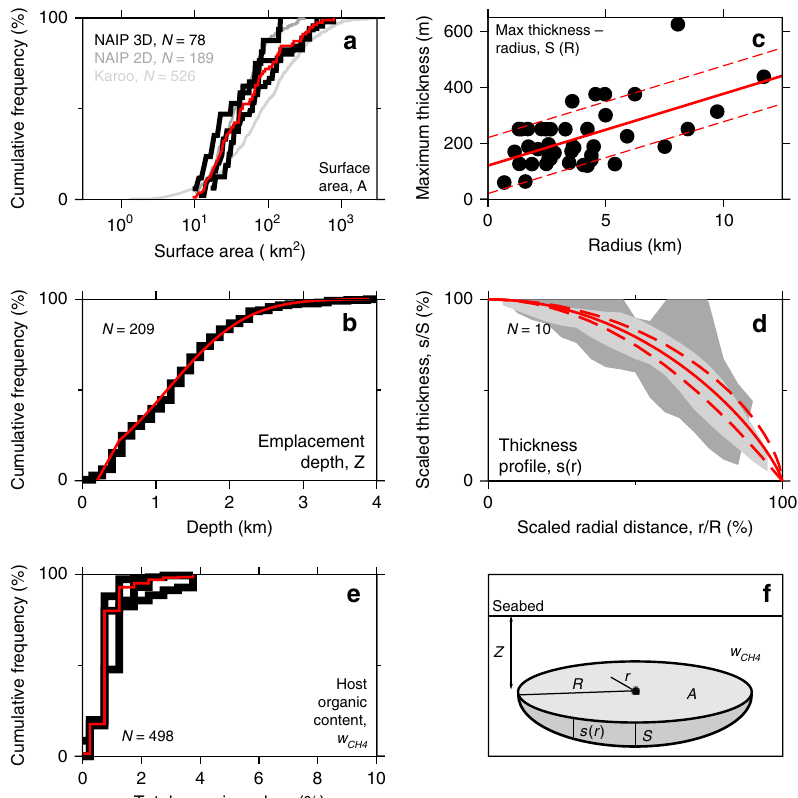
Fig. 4 Sill dimension observations used for stochastic modelling. On all panels, black lines and grey areas show observations, red lines show distributions used in stochastic modelling. a Cumulative distribution of sill surface area. Black lines show observations from three 3D surveys close to the centre of the NAIP, and therefore most likely responsible for peak emissions: Faroe-Shetland Basin (excluding Judd sub-basin), Judd basin and NE Rockall basin. Dark- grey line shows observations from 2D survey compilation from Rockall Basin. Light-grey line shows observations from satellite imaging of Karoo sills (for reference; excluded from de fi nition of red line used for stochastic modelling here). b Cumulative distribution of sill emplacement depth, measured from sills imaged on 2D and 3D seismic data across the NAIP basins and around the world. c Maximum thickness versus diameter for sills for which clear re fl ections from both top and bottom of the sill are observed on seismic data. d Pro fi les of scaled sill thickness versus scaled radial distance. Grey envelopes represent mean ± 1 standard deviation of the stacked scaled pro fi les: dark grey shows sill thickness measured directly; light grey shows sill thickness inferred from forced folds. e Host-rock total organic carbon (TOC) content from 498 samples from the Vøring Basin 33 . The three black lines are the distributions for Paleocene, Upper Cretaceous and Lower Cretaceous rocks. f De fi nition of sill measurement terms. See Supplementary Fig. 2 for an example of how sills are observed and measured on seismic re fl ection